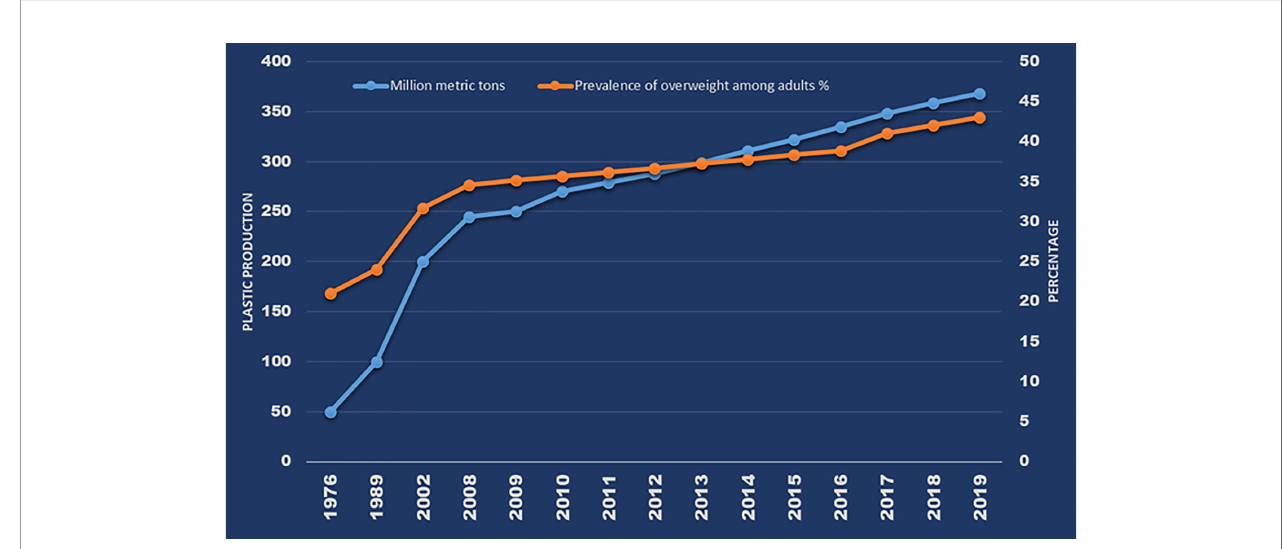
FIGURE 1 | Global annual plastic production and prevalence of overweight over the past 4 decades (Source: Plastics - The Facts 2020, page 16; WHO: https:// apps.who.int/gho/data/view.main.GLOBAL2461A?lang=e; Obesity data from: CDC: